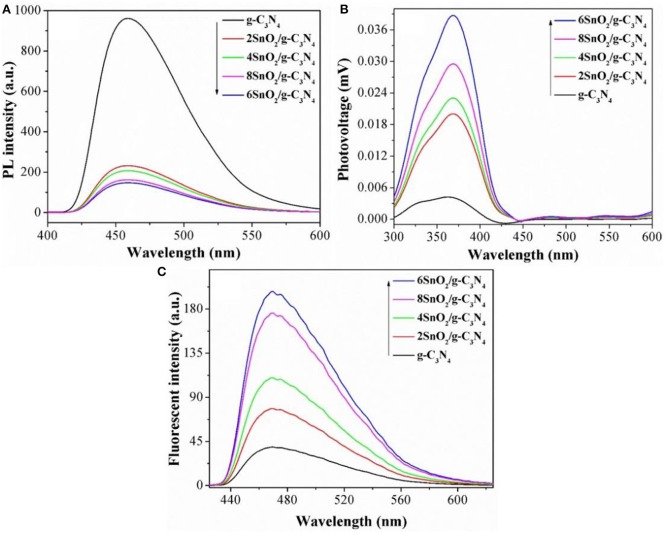
Photoluminescence spectra (A), SS-SPS (B), and coumarin fluorescent spectra (C) of pure g-C3N4 and XSnO2/g-C3N4.